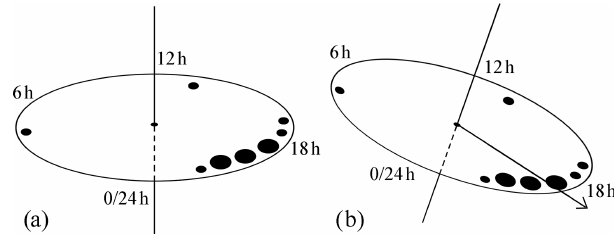
Figure A1. Illustration of “resulting force” algorithm for calculat- ing the average of phase values: (a) diurnal cycle amplitudes are used as “weights” (black dots of different sizes), which are placed on the perimeter of the disc in accordance with the corresponding phase values; (b) when “released”, the disc tilts in the direction of the most frequent phases with the strongest amplitudes.